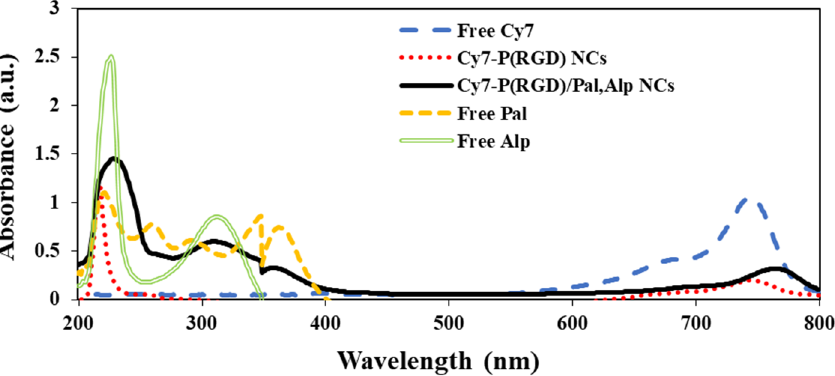
Figure 6. Absorbance spectra of free Cy7 (blue light-dashed line), Cy7-conjugated P(RGD) NCs (red dotted line), Pal (orange dashed line), Alp (green hollow line) and Cy7-conjugated P(RGD)/Pal,Alp NCs (black solid line).